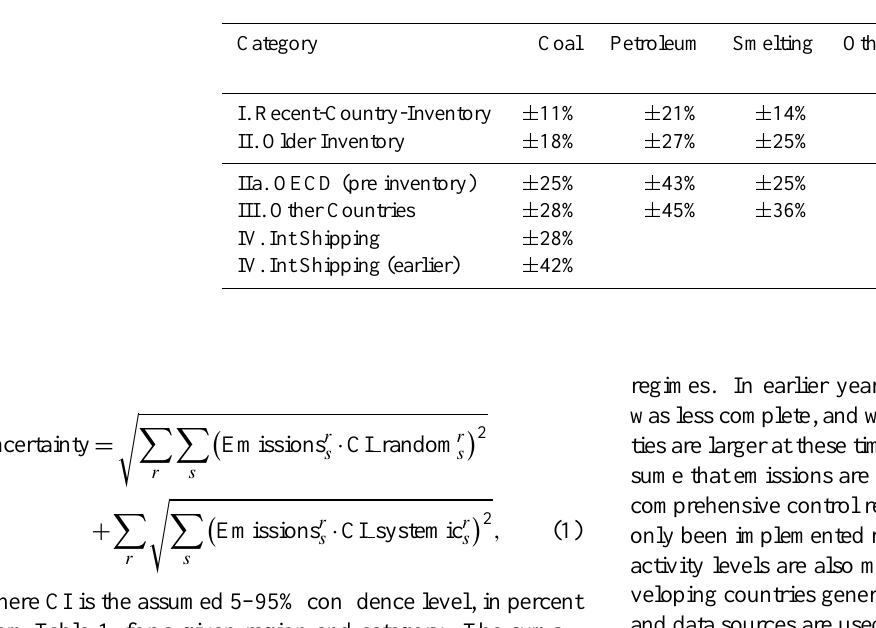
Table 1. Uncertainty bounds (as 95% confidence interval) by country category and emissions type. The uncertainty bounds shown in the table are used for random effects in Eq. (1). An additional systemic uncertainty was added (see text) with a magnitude of 2.5% for countries with category I inventories, and 5% for all other countries (and all countries prior to